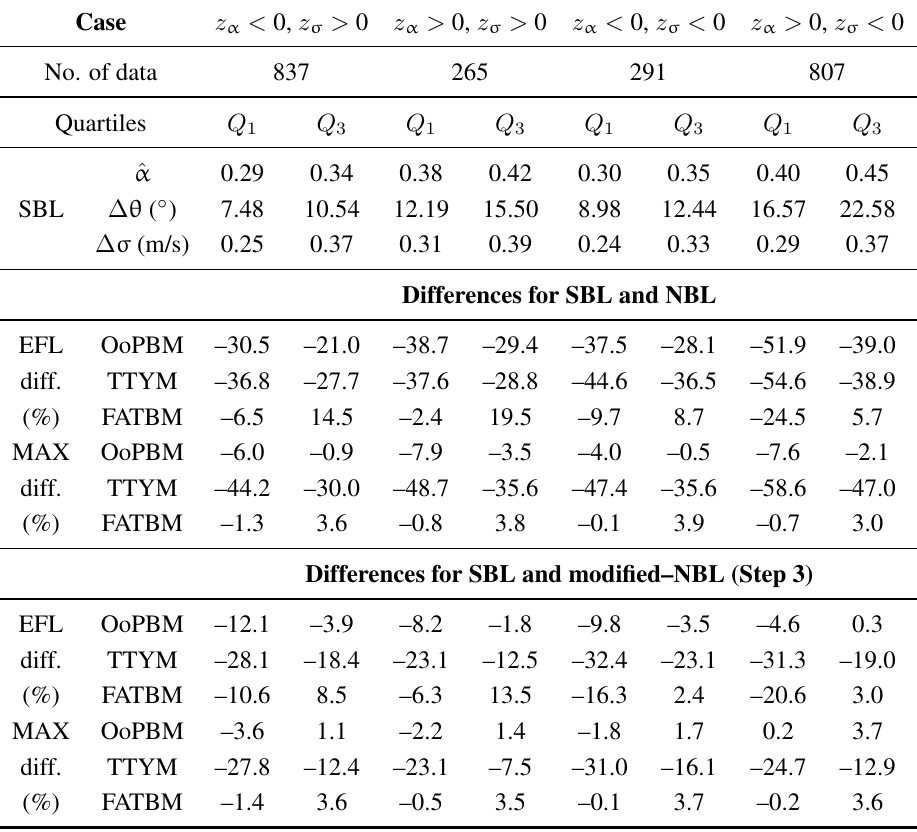
Table 5. Summary on relationships between SBL wind field characteristics and percentile differences in wind turbine load statistics estimated from the various wind fields; Q represent the first and third quartiles, respectively; diff. (%) = 100 · ( L where L represents an equivalent fatigue load (EFL) or a 10-min maximum load